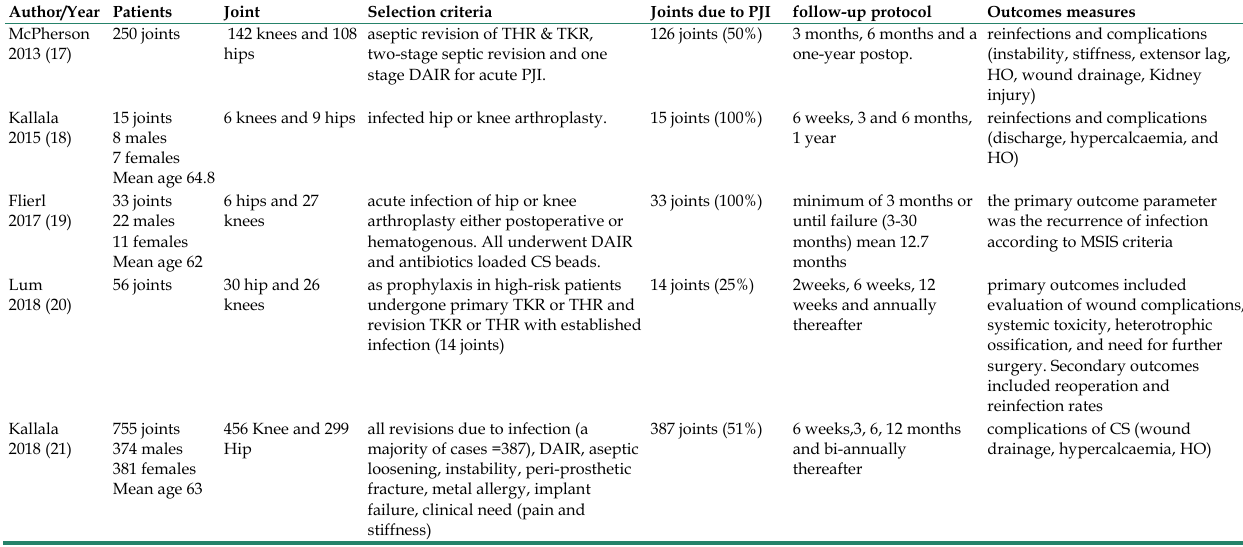
Table 2. Studies description.